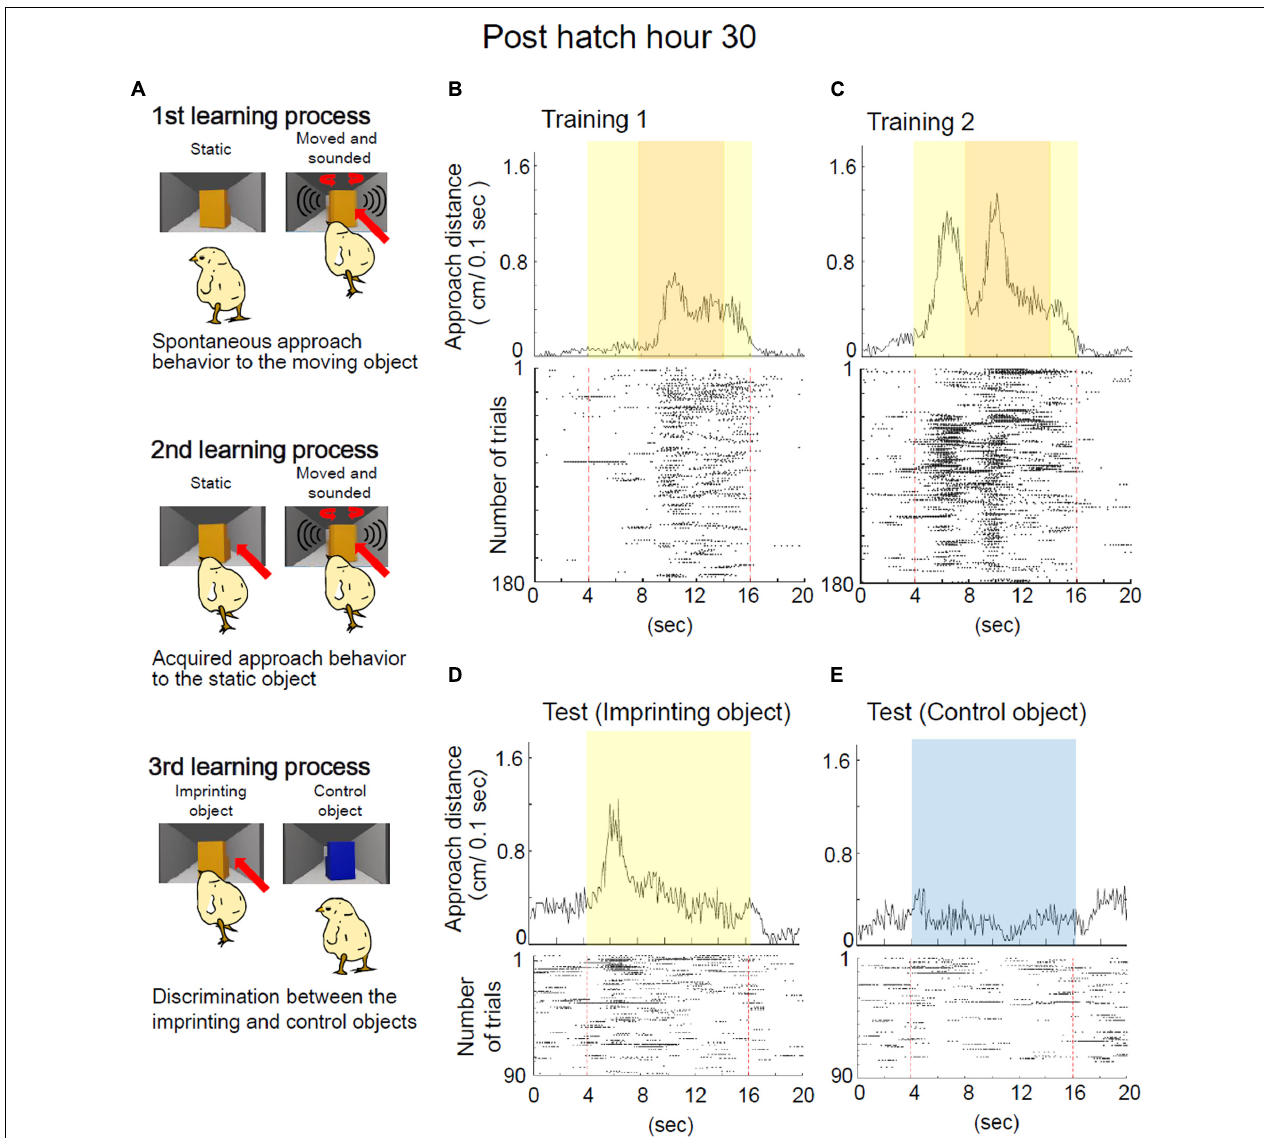
FIGURE 2 | Definition of learning processes in filial imprinting. (A) Three learning processes for the imprinting were defined. In the first process, the chick approaches spontaneously the moving object in the training, but does not approach the static object. In the second process, the chick becomes to approach the static object in the training. In the third process, the chick discriminates the imprinting object from the control object. Representative behavior of a chick at Phh 30 in the imprinting training and test are shown in panels (B–E) . (B) Averaged approach distances in training 1 are shown in the upper column. Raster plots of each trial are shown in the lower column. One plot indicates the timing of a 1/10 turn of the disc. Red broken lines indicate the onset and offset of the object presentation. In the initial part of training 1, a chick at Phh 30 responded to the object only when it was moving. In some trials of training 1, the chick responded to the object before the object started moving. (C) Averaged approach distances and raster plots of each trial in training 2 are shown. In training 2, the chick responded to the static object more frequently than the chick in training 1. (D) Averaged approach distances and raster plots in the imprinting object trials of the test are shown. The chicks responded constantly to the static state of the yellow object. (E) Averaged approach distances and raster plots in the control object trials of the test are shown. The chick responded to the static state of the blue object in several initial trials, but gradually stopped